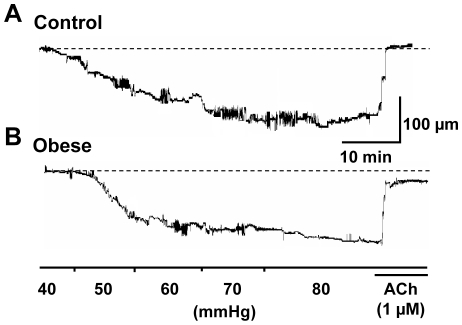
Myogenic response.Representative traces of myogenic tone development in arteries from control (A) and obese (B) animals with stepped pressure increases. At 80 mmHg, no difference was observed in the degree of constriction in control compared to obese arteries, with ACh (1 µM) relaxing arteries from control and obese rats.